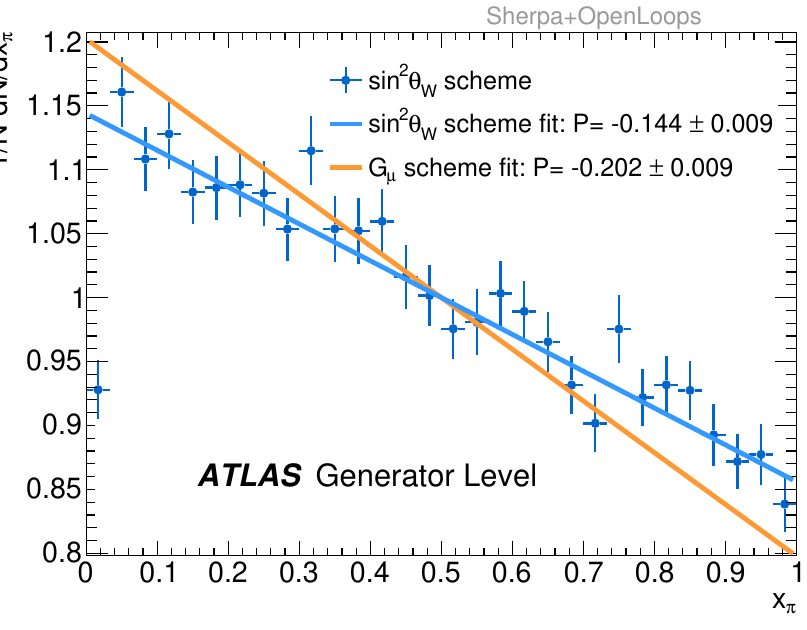
for the G and sin 2 θ EW π µ eff scheme are shown. The fitted values are shown eff